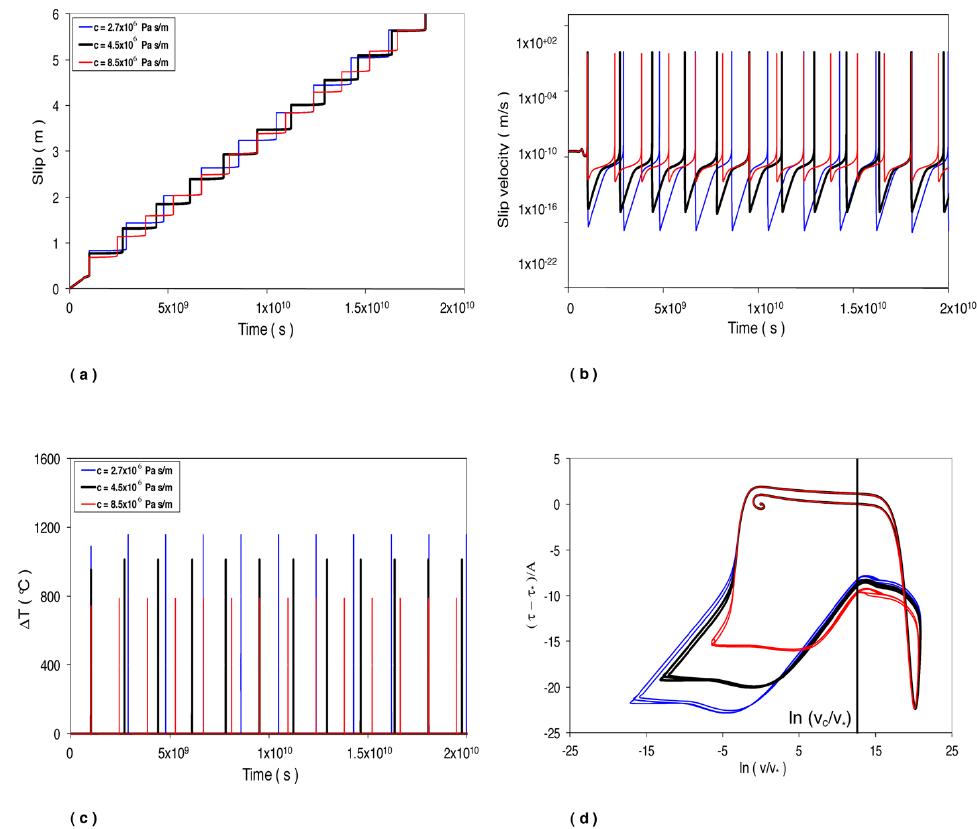
Figure 4. Comparisons between the numerical simulations for the CH law (Equation 7) with RDT for Configuration A, using different values of c (the radiation damping coefficient from Equation 3) at the reference value of v . (a) Slip displacement versus time. (b) Time history of the slip velocity (on a c logarithmic scale). (c) Time history of the temperature developed by frictional heating. (d) Phase portrait. Black, reference configuration (see Table